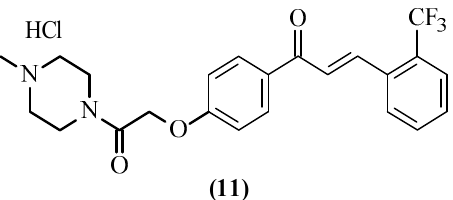
Figure 2. A synthetic chalcone derivative as an Nrf2